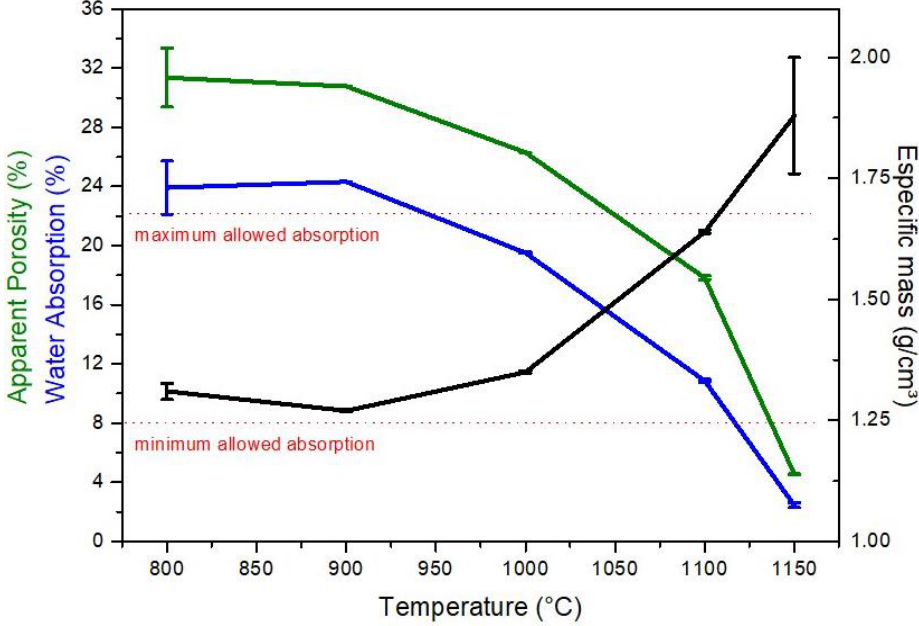
Figure 9. Results of apparent porosity, water absorption, and specific mass tests.